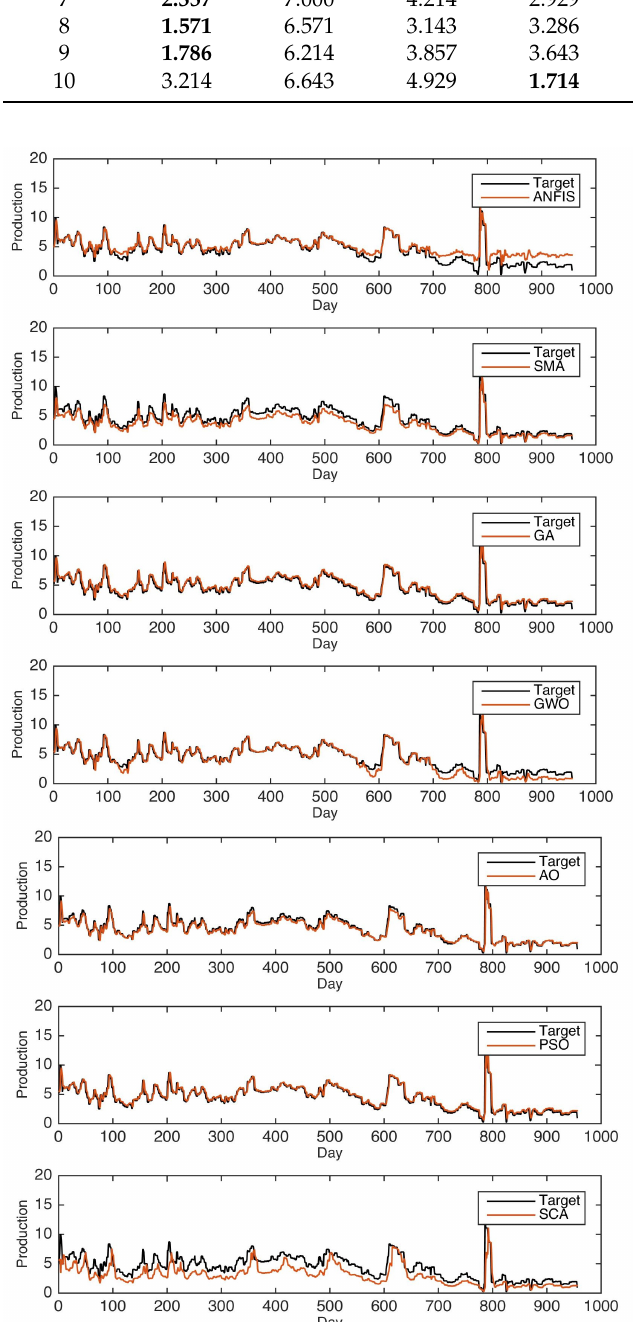
Figure 6. The results of the AO and the compared models for well No. 1., Tahe